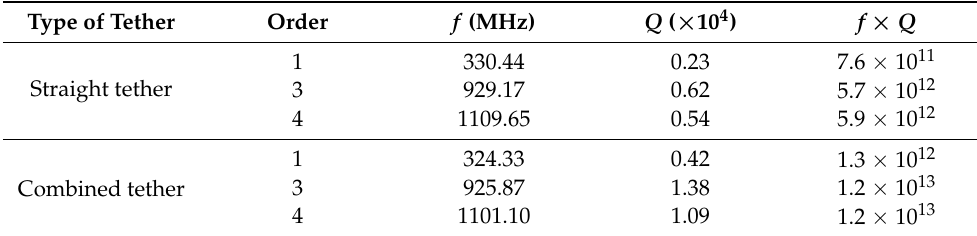
Table 3. Performance of the WEM resonators of different orders.